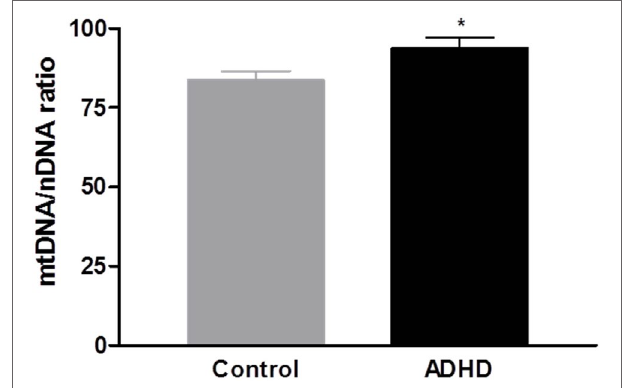
FIGURE 1 | Comparison of the mitochondrial DNA (mtDNA) to nuclear DNA (nDNA) ratio in peripheral blood between attention-deficit hyperactivity disorder (ADHD) and control groups.* p < 0.05.